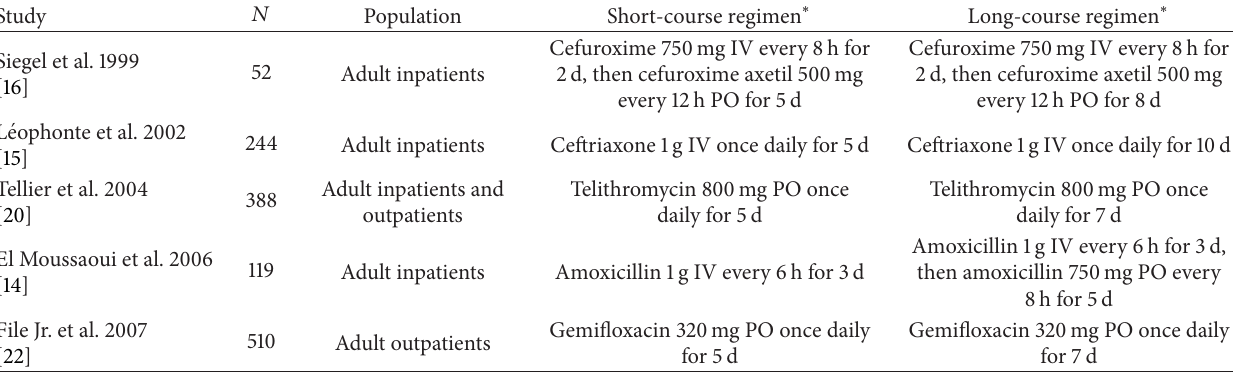
Table 2: Studies comparing the efficacy of short-course versus long-course antimicrobial regimens for the treatment of CAP, using the same dose of the same drug for a different length of